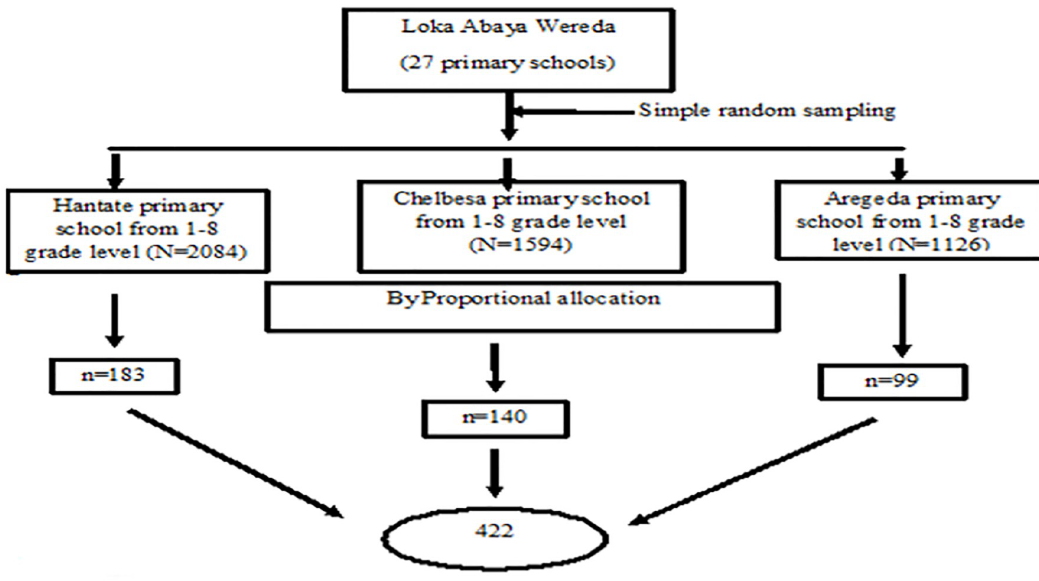
Fig 1. Schematic presentation of sampling procedure to determine the prevalence and associated risk factors of G . lamblia infections from selected government elementary schools located in Loka Abaya town, Sidama zone, SNNPR,